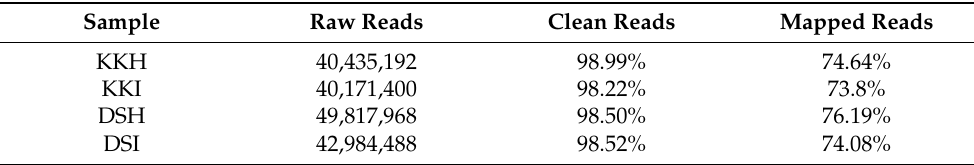
Table 1. Total raw, clean, and mapped reads obtained from each sample. Sample Raw Reads Clean Reads Mapped Reads KKH